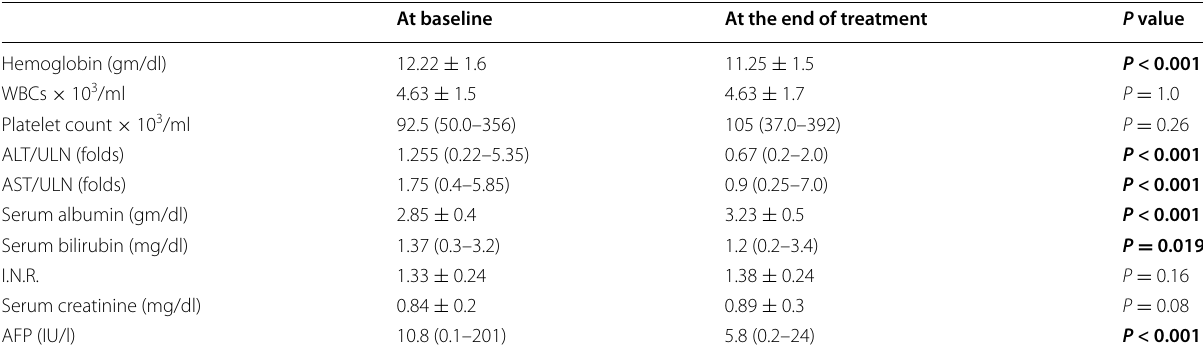
Table 3 Comparison between laboratory results at baseline and at the end of treatment among the studied patients